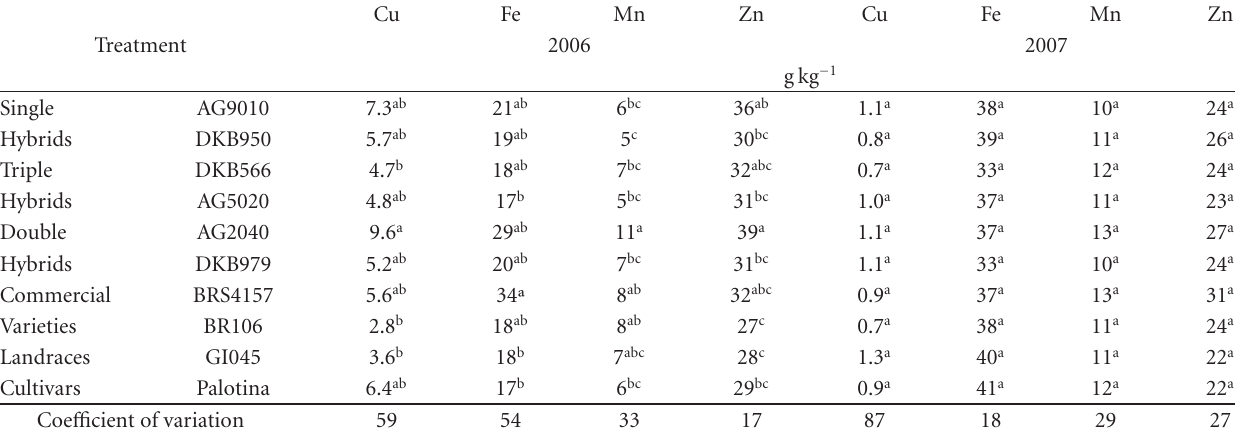
Table 3: Grain micronutrient concentrations for 10 corn cultivars representing five di ff erent technological levels in 2006 and 2007, at Rolandia County, Parana State, Brazil.